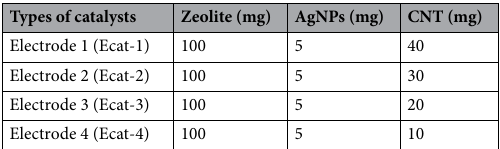
Table 1. Experimental condition for the synthesis of